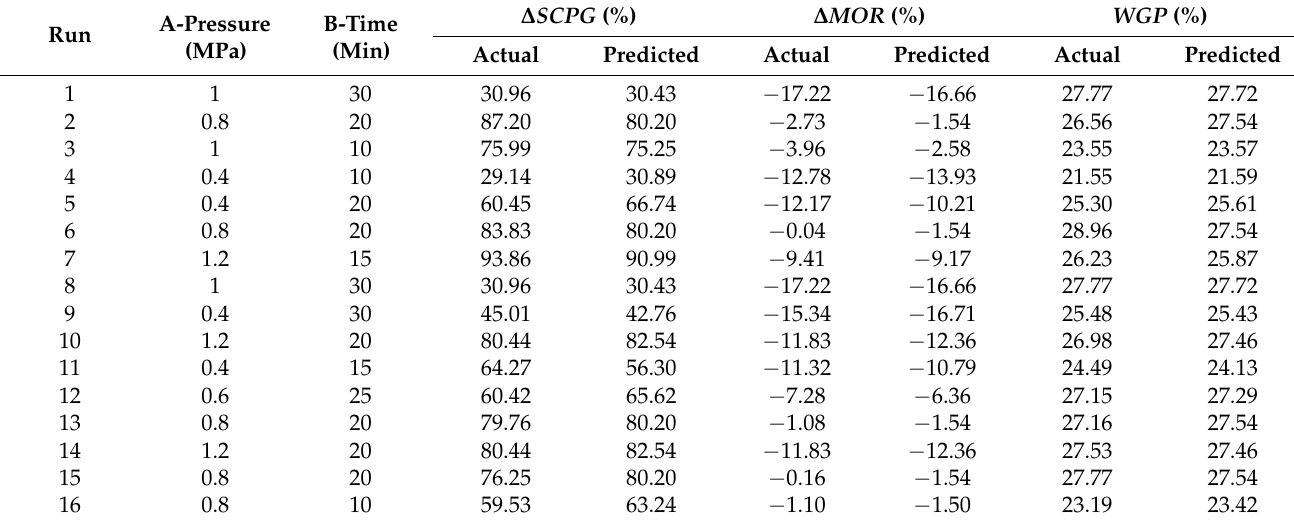
Table 2. Results of the response surface experiment.